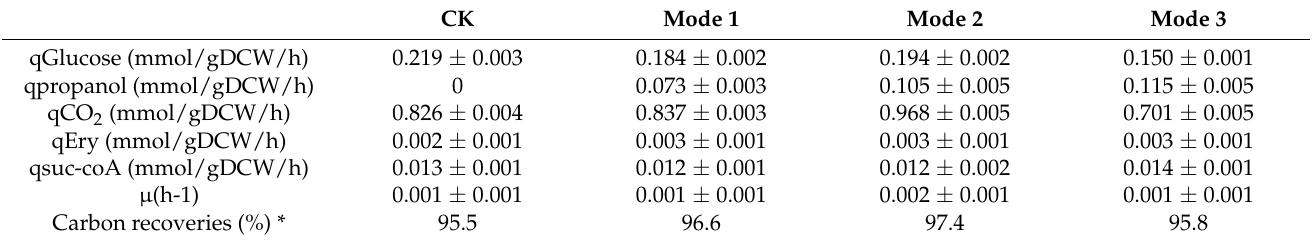
Table 4. Variation rate and carbon recovery rate of each group of engineered strains E3- ∆ sucC during 96–108 h.